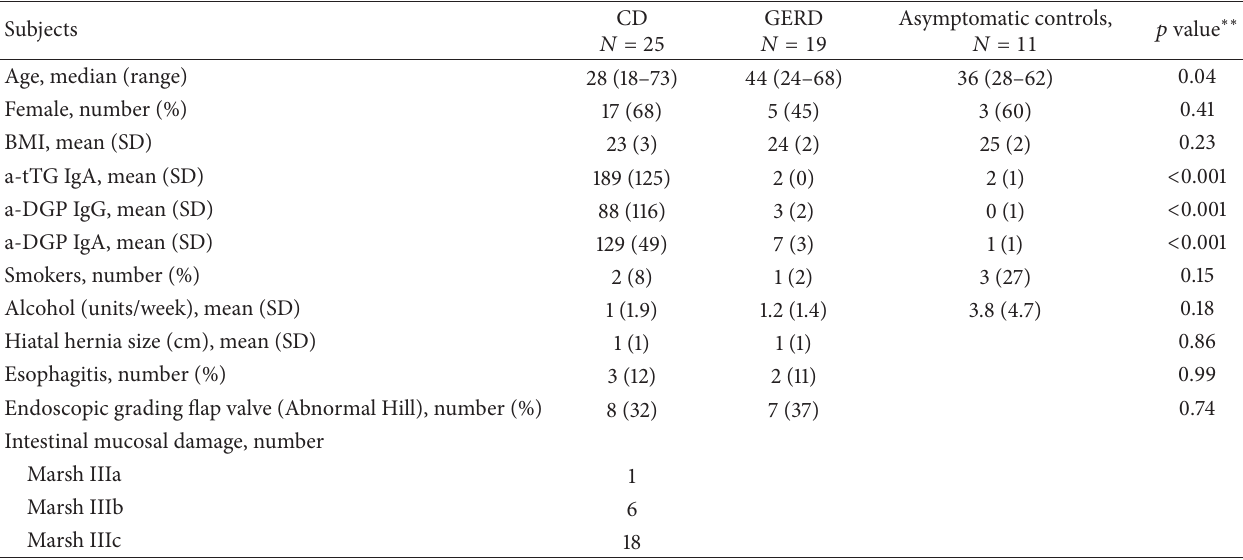
Table 1: Characteristics of the study